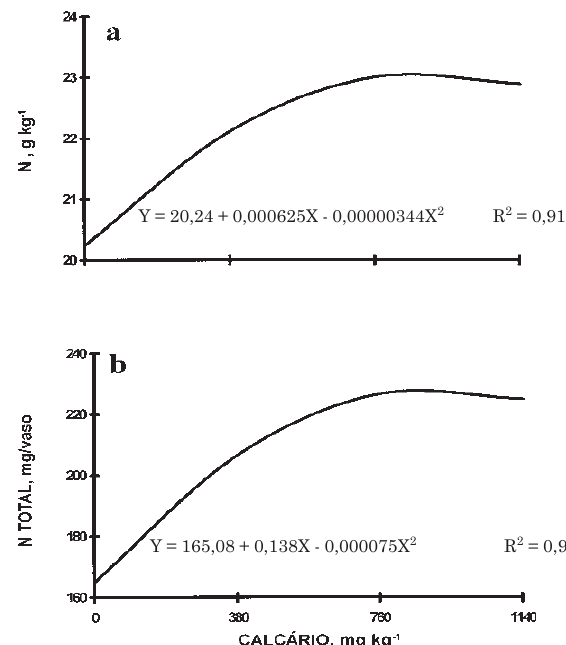
5. Concentração (a) e quantidade total (b)